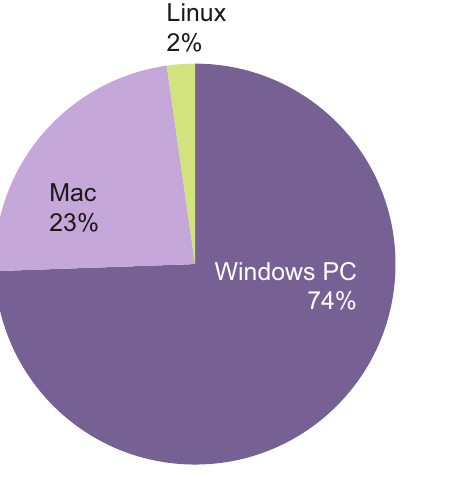
Figure 2. Breakdown of operating systems used by researchers surveyed. n = 133.